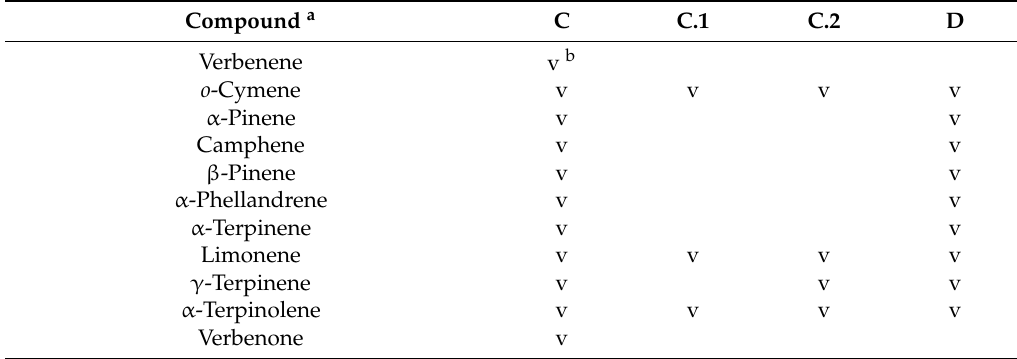
Table 1. Comparison of a fresh sample of Bursera cuneata copal (C), a five-year-old sample (D), and samples given two different artificial treatments (sample C.1, prepared by dissolving resin in turpentine and sample C.2, obtained heating the resin at 100 ˝ C for 10